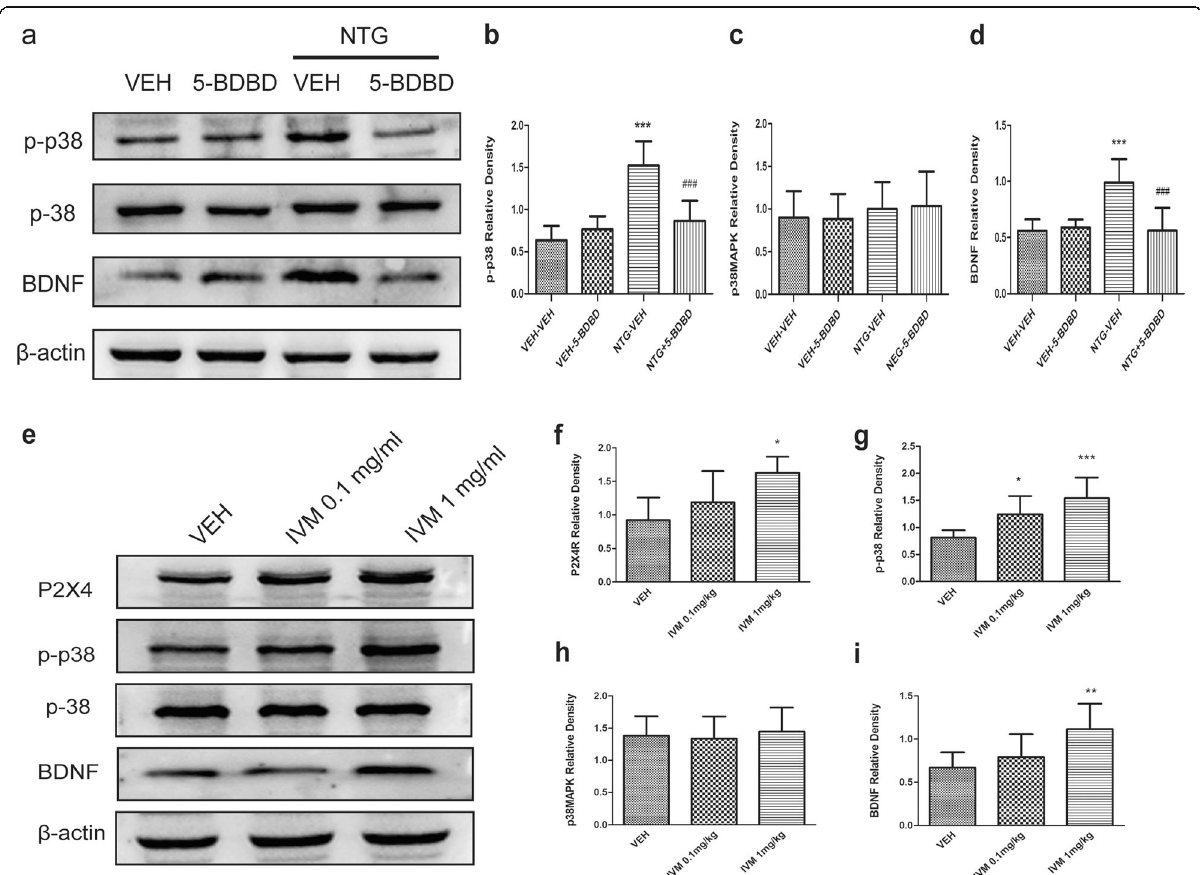
Fig. 8 The levels of p38, p-p38-MAPK and BDNF after pharmacological inactivation or activation of P2X4Rs. a Representative images of Western blot results showing the expression of p38, p-p38 and BDNF proteins after 5-BDBD treatment. b - d The histogram presents the quantitative analysis of p-p38 ( b ), p38MAPK ( c ) and BDNF ( d ) in the TNC. n = 5/group. *** p < 0.001 versus VEH-VEH, ### p < 0.001 versus NTG-VEH. ( e ) Representative images of Western blot results showing the expression of P2X4, p38, p-p38 and BDNF proteins after IVM treatments. f - i The histogram presents the quantitative analysis of P2X4 ( f ), p38 ( g ), p-p38 ( h ) and BDNF ( i ) in the TNC. Data are presented as the mean ± SD. n = 6 – 8/group, One-way ANOVA and Tukey ’ s multiple comparison test. * p < 0.05, ** p < 0.01, *** p < 0.001 versus